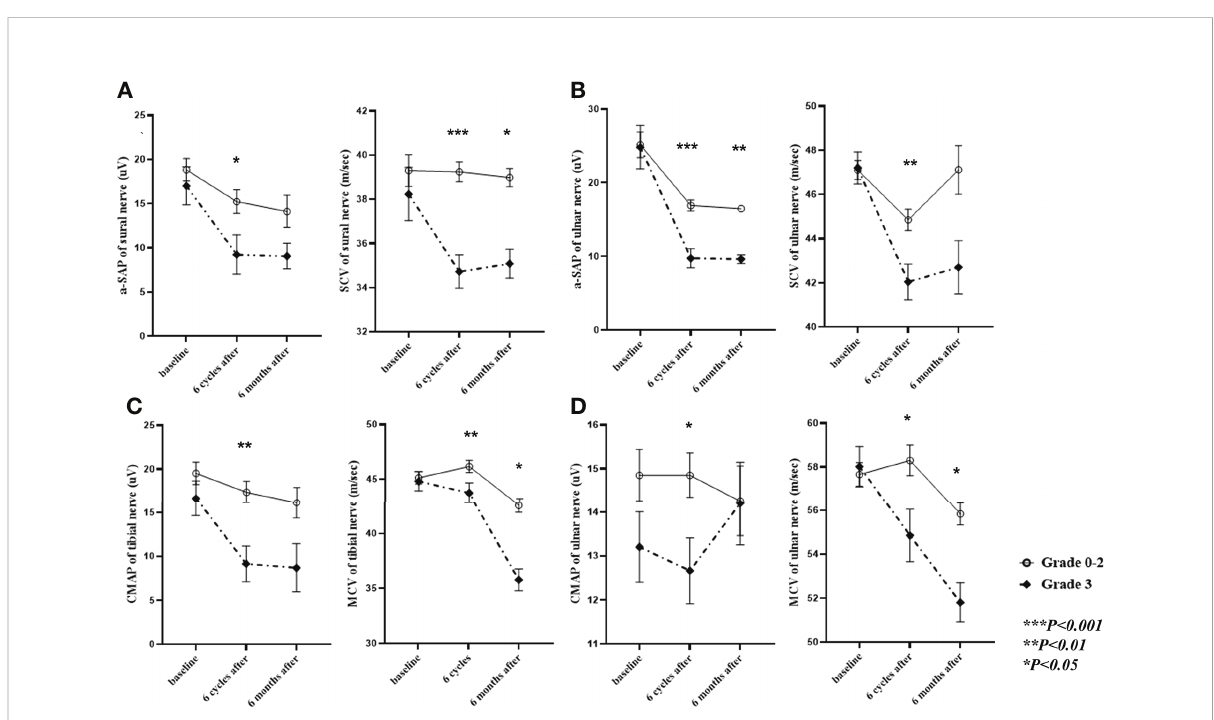
FIGURE 2 Nerve conduction studies in grade 3 vs. grade 0 – 2 PIPN patients. Shown is a comparison of a-SAP and SCV in the (A) sural and (B) ulnar nerves and of CMAP and MCV in the (C) tibial and (D) ulnar nerves between patients with grade 3 and grade 0 – 2 paclitaxel-induced neuropathy. The data collected at baseline, during, and 6 months after paclitaxel treatment have been adjusted for age and presented as mean ± standard error. PIPN, paclitaxel-induced peripheral neuropathy; a-SAP, amplitude of the sensory nerve action potential; SCV, sensory nerve conduction velocity; CMAP, compound muscle action potential; MCV, motor nerve conduction